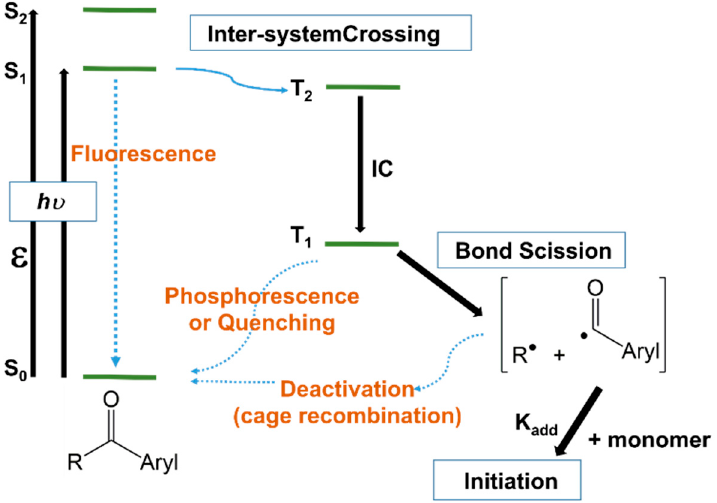
Figure 3. Jablonski diagram illustrating the photoinitiation of a type I acetophenone initiator.